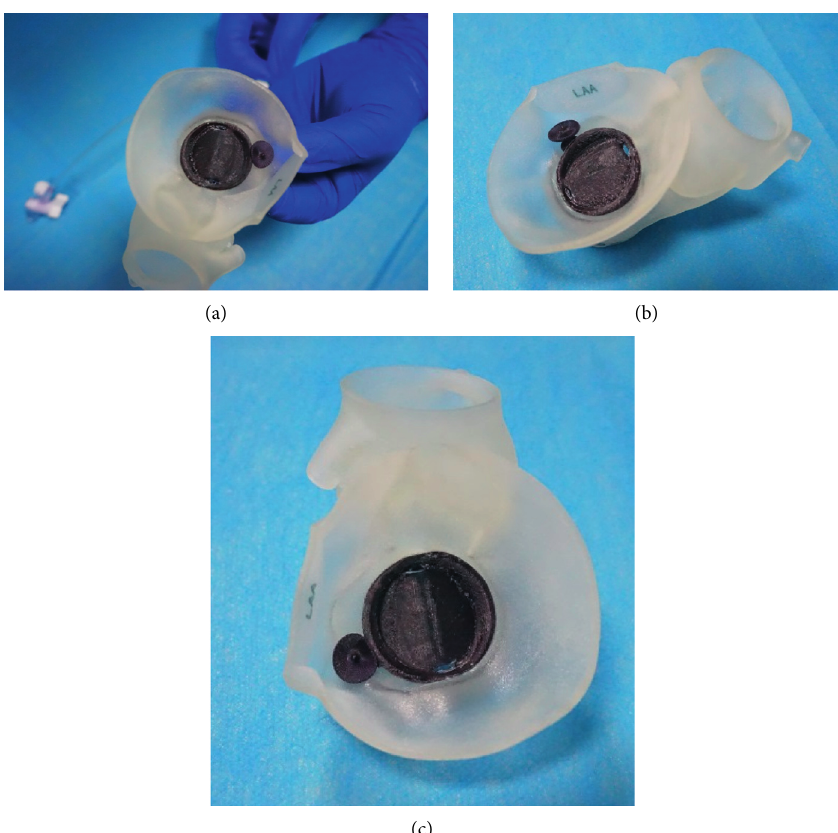
Figure 8: The 3D printing model of patients was made based on the postoperative CT results. The operator observed the position of the occluder device in vitro and evaluated the results of the operation.